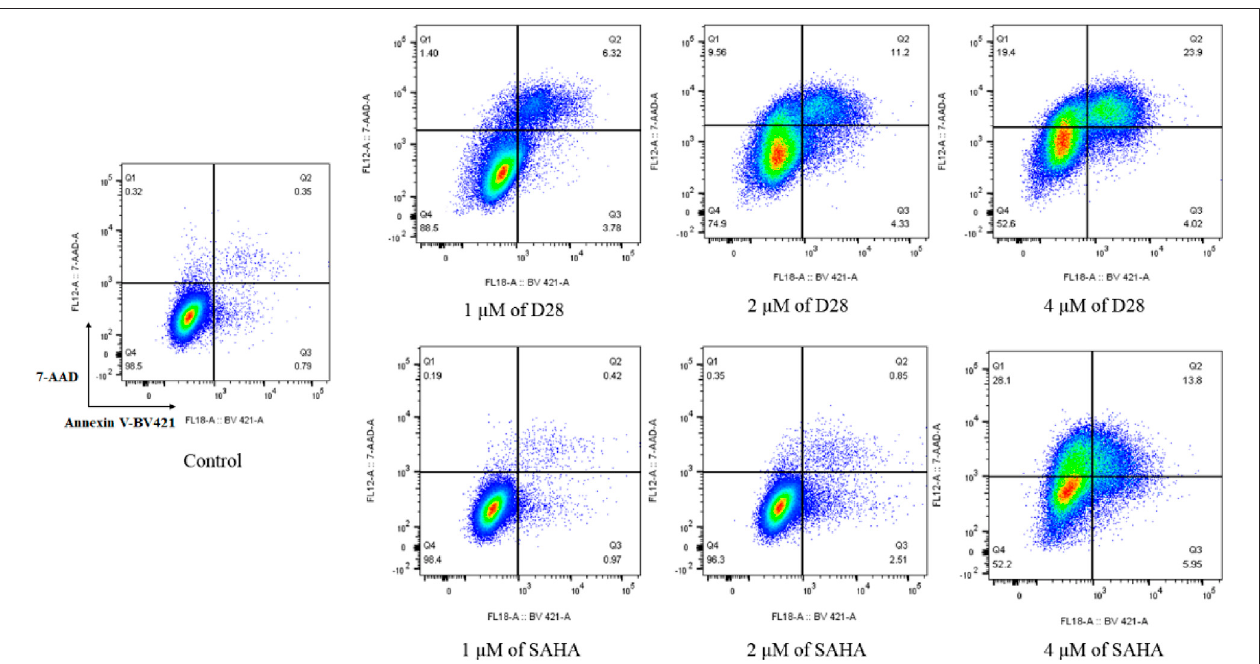
FIGURE 4| Molecule D28 induces cellular apoptosis ofK562 cells. Cells were treated with 1.0, 2.0 and 4.0 µM of D28 and SAHA for 24 h, and cell apoptosis was determined by fl ow cytometric analysis.